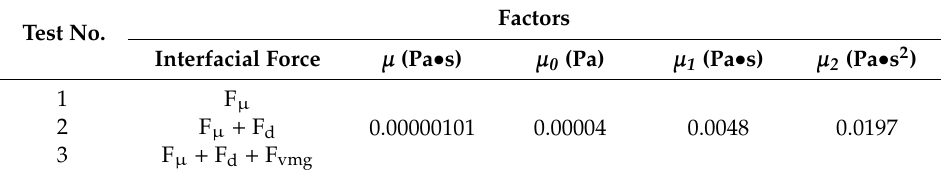
Table 1. Experimental conditions (viscosity values and interfacial force model) adopted for this study